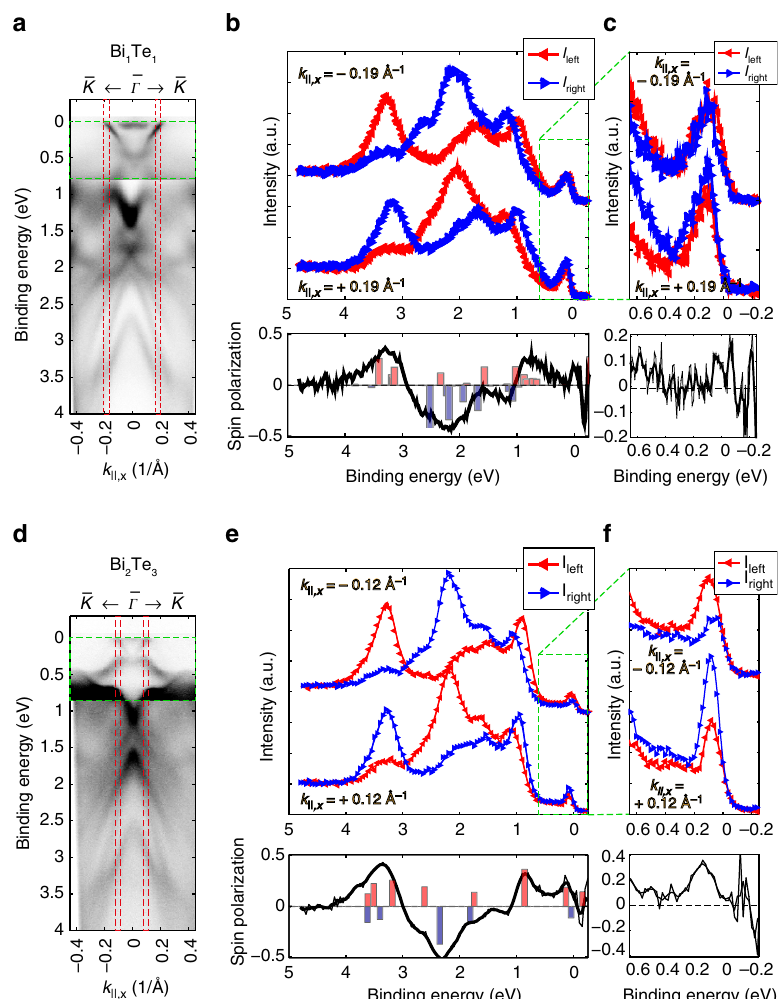
Figure 5 | Spin-ARPES measurements recorded with h n ¼ 22eV and a four-channel SPLEED polarimeter. Wide range ARPES spectra of ( a ) Bi 1 Te 1 and ( d ) Bi 2 Te 3 as shown in Fig. 3b,a for the illustration of the k -points k ||, x ¼ ± 0.19Å (cid:2) 1 and k ||, x ¼ ± 0.12Å (cid:2) 1 (red dashed lines) along which the in-plane spin polarization was measured. Note that the first 800meV below the Fermi level were boosted in contrast (green dashed area). ( b , e ) Wide energy spin- polarized EDCs at the indicated two opposing k -points, and effective net spin polarization below. The bar graph in the latter shows the calculated spin polarization. c , f Magnified EDCs and spin polarization close to the Fermi level according to area marked in green in b , e